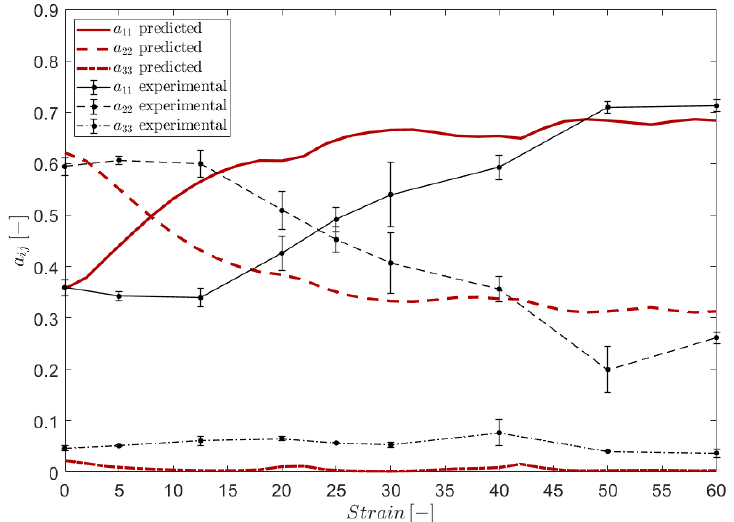
Figure 11. Experimental (black) and predicted (red) fiber orientation evolution of compression molded samples [43].